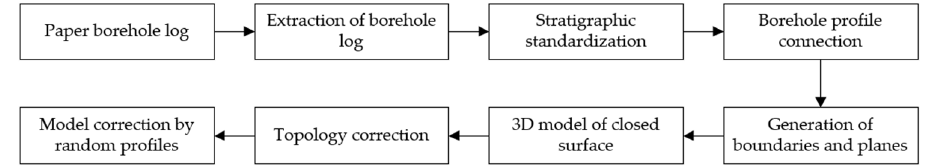
Figure 3. 3D geological modeling flow based on a papery borehole log.